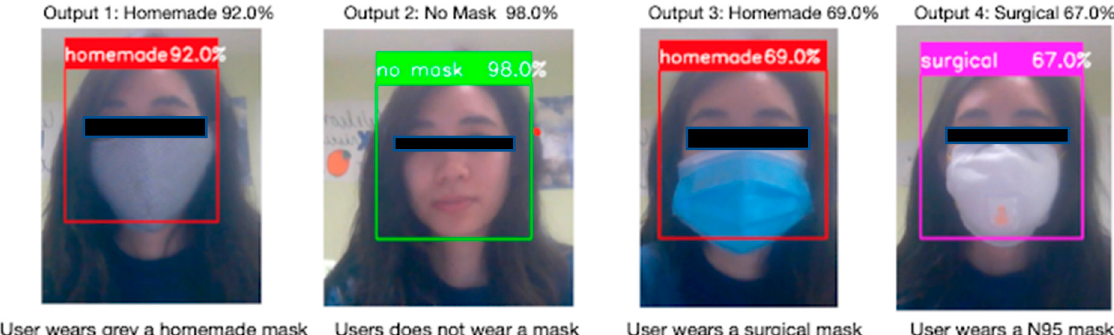
Figure 20. Mask Type Detection in different scenarios.